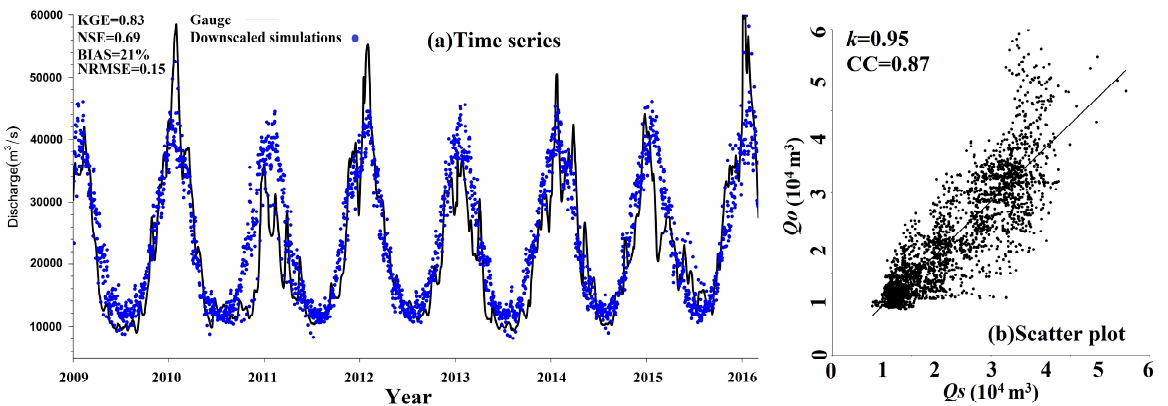
Figure 9. ( a ) Time series and ( b ) scatter plot between downscaled discharges from the hybrid model at the VS077 and observed discharges at the Huangshigang station during 2009–2016. Note: The discharge data was normalized and divided by the maximum discharge for intuitive comparison. The black line in subfigure ( b ) indicates the fitted linear regression line. k is the slope of the linear regression line.